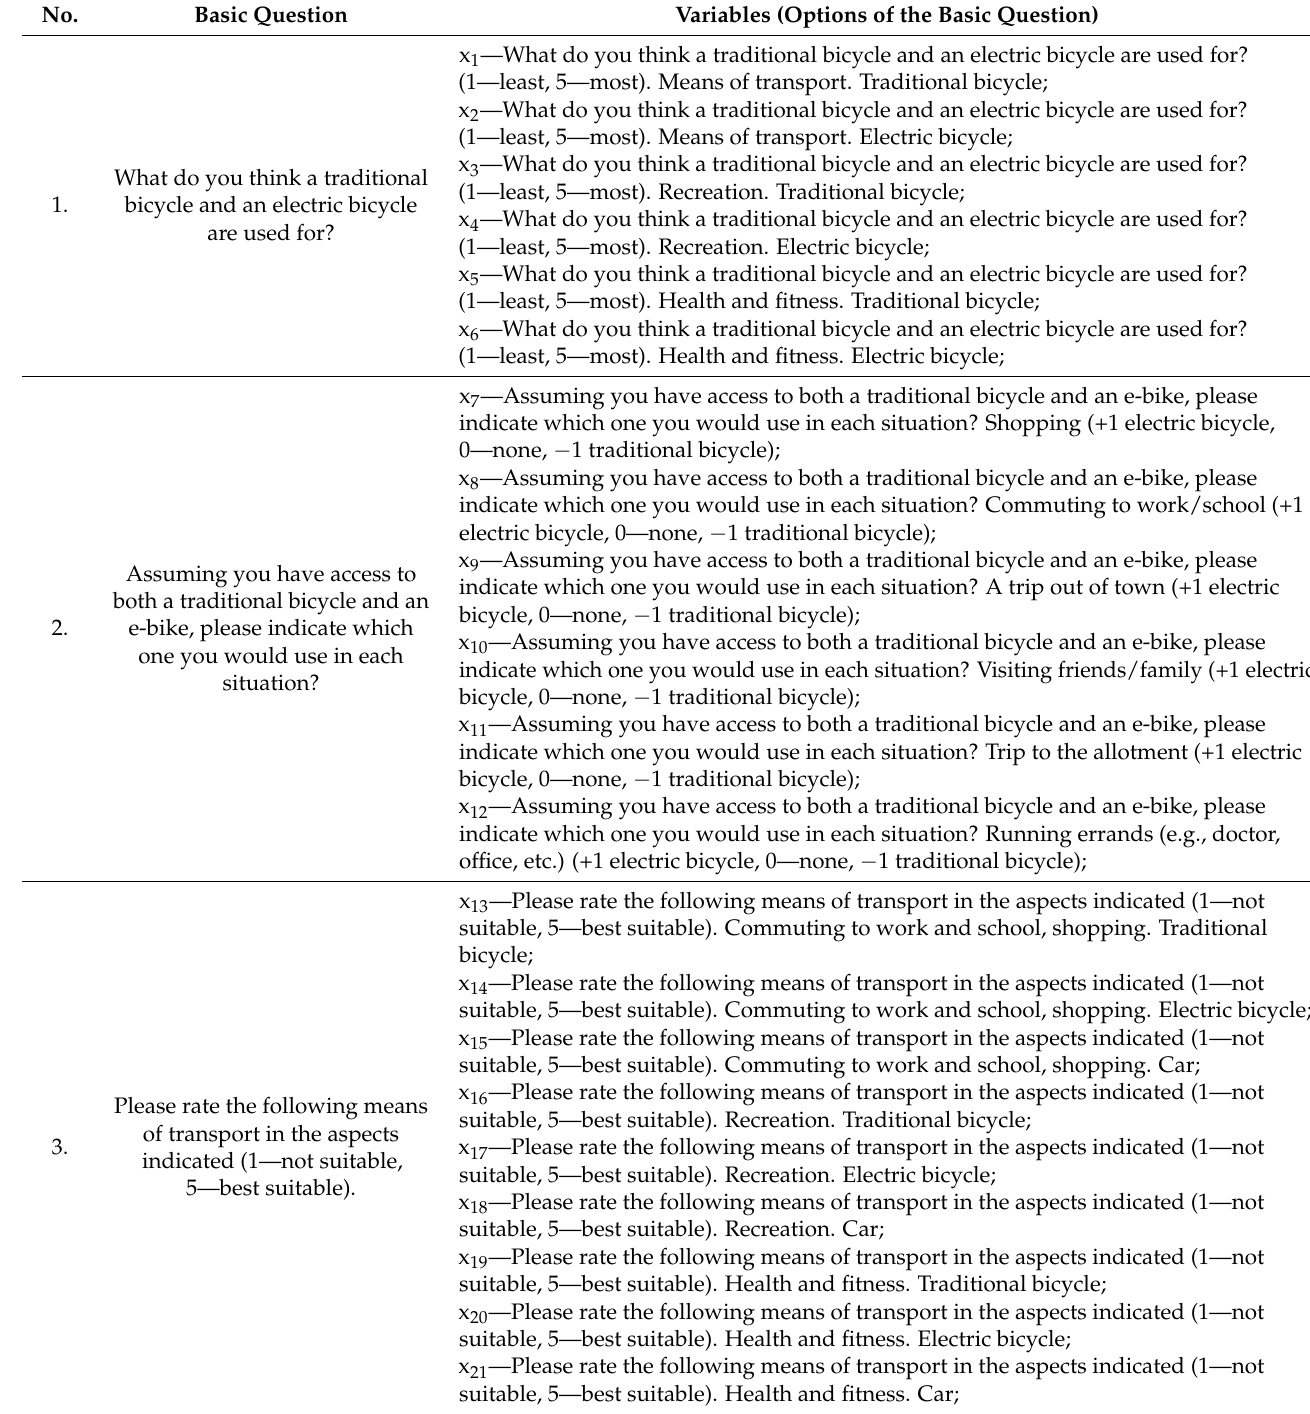
Table 1. List of questions and variables employed in the